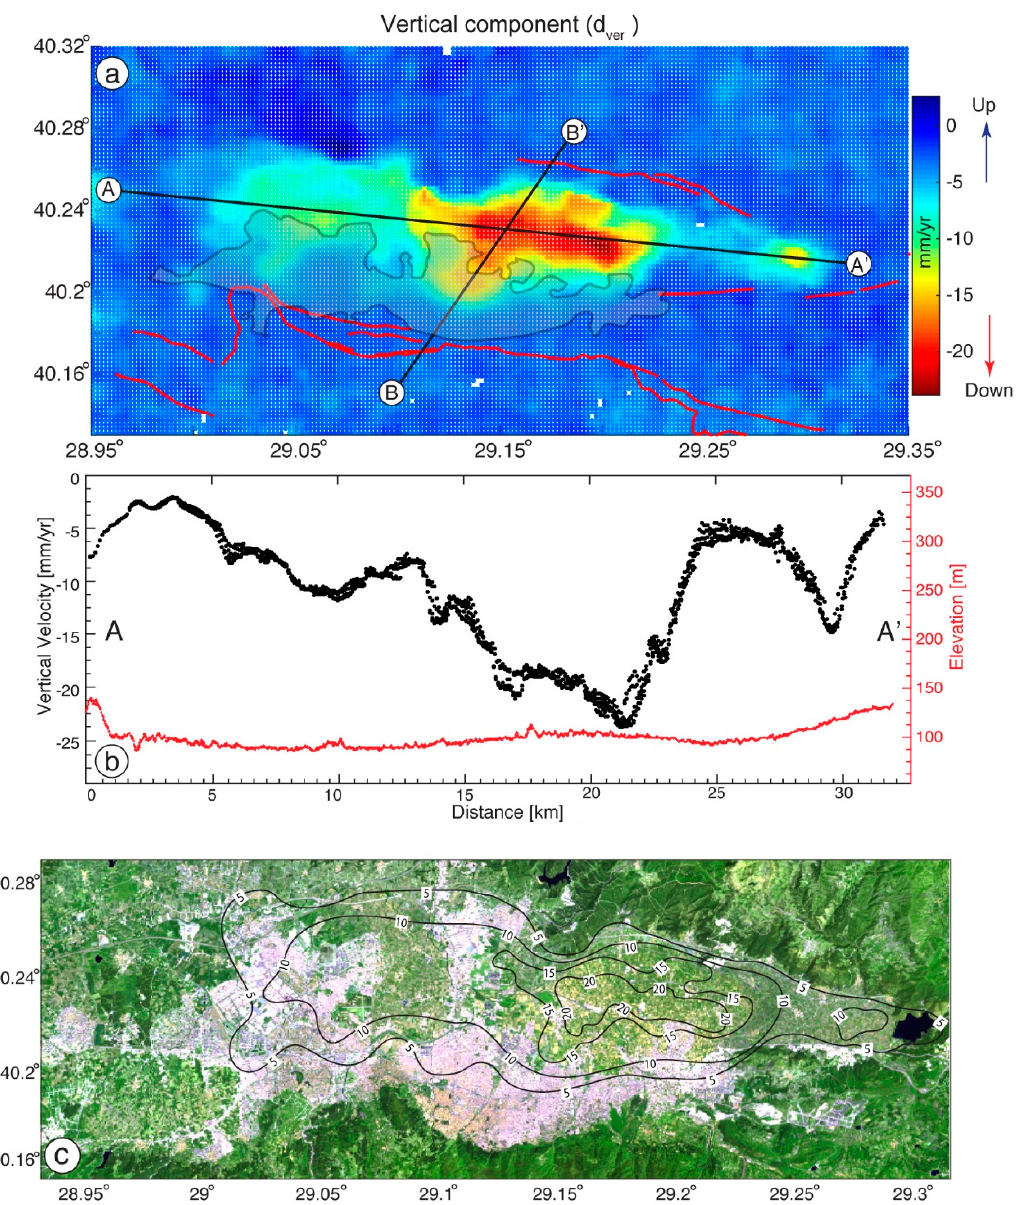
Figure 5. Decomposition of LOS velocities into vertical component for Sentinel-1 data during the time period of 2014–2017. ( a ) Vertical mean velocity map. The warm colors represent the land subsidence relative to the reference area. The shaded area shows the Bursa city AA’ profile is shown in ( b ), BB’ profile in Figure 9. ( b ) East-west AA’ profile showing vertical displacement rates in black and altitude in red. ( c ) 5 mm/yr interval contour maps superimposed onto Landsat 8 image of 23 April 2018, in RGB combination of bands 7, band 6, and 4. Agriculture areas appear in shades of light green and yellow during the growth season and are located where the subsidence is the highest. Urban areas are in white, gray, or light purple colors [70].